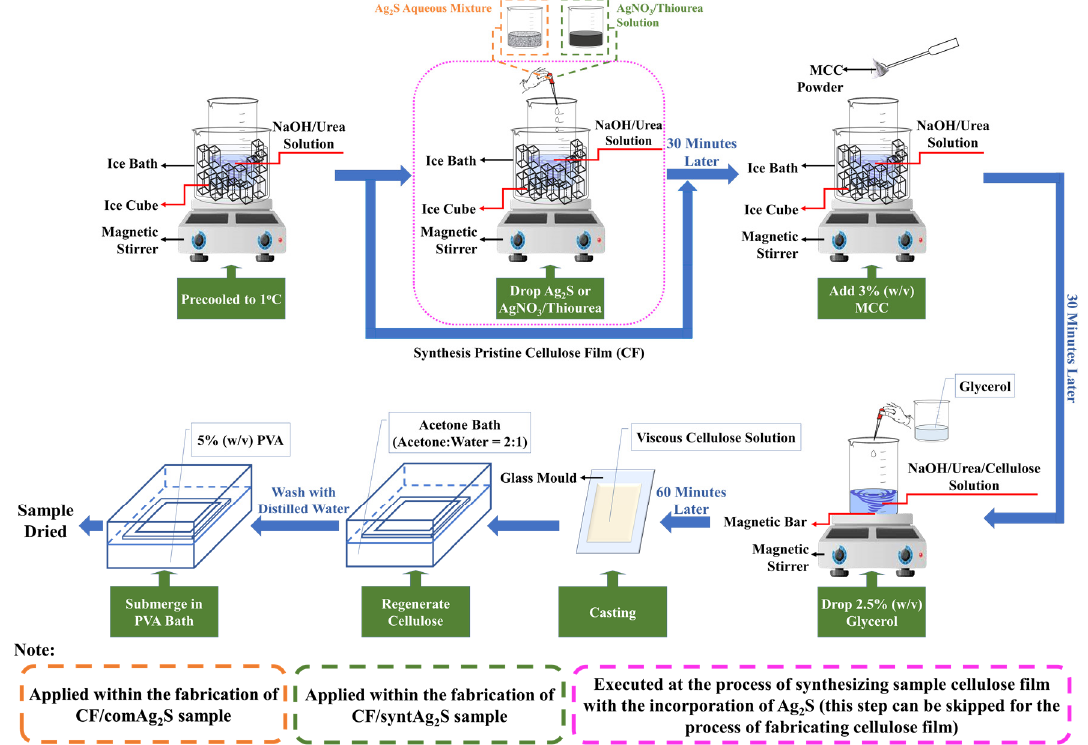
Figure 1. Schematic illustration of sequence process to synthesize the